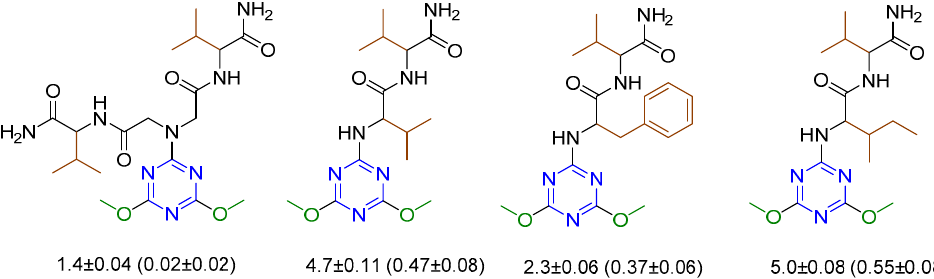
Figure 7. Compounds active against antileishmanial activity. The values are measured as IC 50 in µM for anti-promastigote (anti-amastigote) activity.